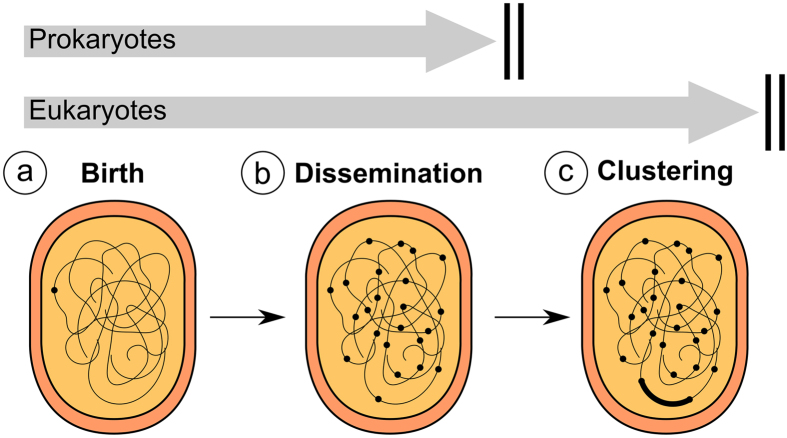
Hypothesis on satellite DNA evolution, based on the fact that all kinds of elements can be found clustered or non-clustered, at cytological level, and show many common satellitome properties.The birth of a satDNA implies a de novo duplication of a genomic sequence of two or more bp. This can occurs, for instance, by means of replication slippage in the case of short satDNAs or rolling circle replication in the case of long ones. This gives rise to a short array (<1.5 kb, i.e. the sensitivity FISH threshold) at a single genomic location (small dot in (a)). This short array is then disseminated throughout the genome by unknown mechanisms, although transposable elements or rolling circle replication and reinsertion elsewhere might be good candidates (b). All satDNAs remain at this stage in prokaryote species, where genomic constraints and natural selection (represented by double vertical bars) pose rigid limits to satDNA accumulation, and some of them remain this way in eukaryotes appearing as non-clustered satDNAs (b). In eukaryotes, however, any of the short arrays can undergo local amplification surpassing the 1.5 kb thus becoming into a clustered satDNA and being visible by FISH (c). The fact that all clustered satDNAs found in the L. migratoria genome were found in many different contigs of the assembled genome provides strong support to the hypothesis that dissemination precedes clustering. Local amplification implies rapid increase in array size and could take place, for instance, by unequal crossing over. Based on our simulation of random genomes of the L. migratoria size, satDNA arrays of 15 bp or less can appear by chance at many genomic locations (>15) (Supplementary Table S9). For this reason, all microsatellites and the shortest minisatellites can start their life-cycle at stage (b). Of course, further research is necessary to unveil the precise mechanisms involved in reaching each stage, as those included here are only suggestions based on current literature.